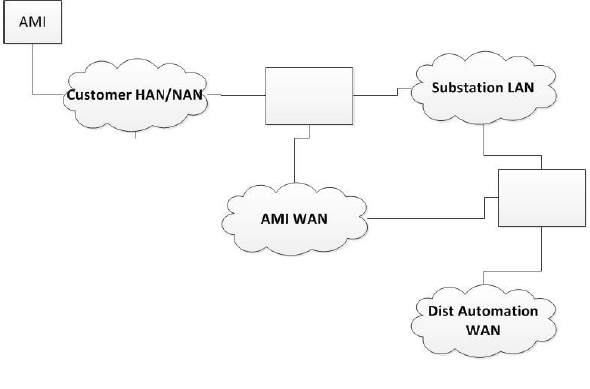
Figure 2. Simple Smart Grid Communication